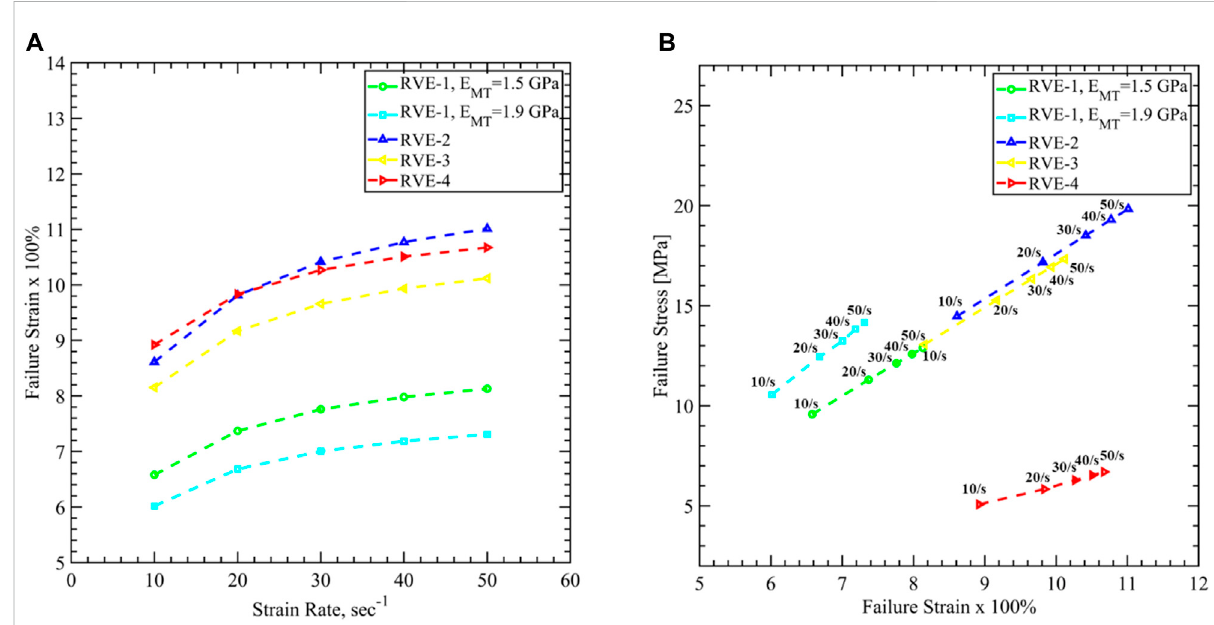
FIGURE 17 Axon cytoskeletal damage evaluation by mapping damage threshold values for (A) axon volume averaged failure strain vs. strain rate, and (B) axon volume averaged failure stress vs . axon volume averaged failure strain for different RVEs. 40% strain is taken as the failure strain of Tau, and corresponding axonal stress and strain are plotted for different loading